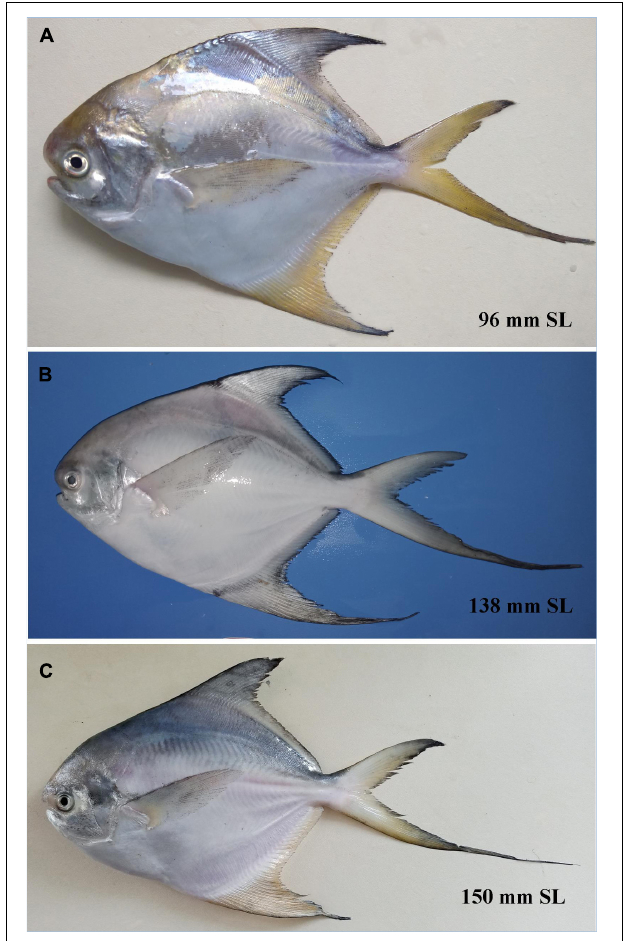
FIGURE 8 | Pampus candidus . (A) Juvenile, and (B,C) adult